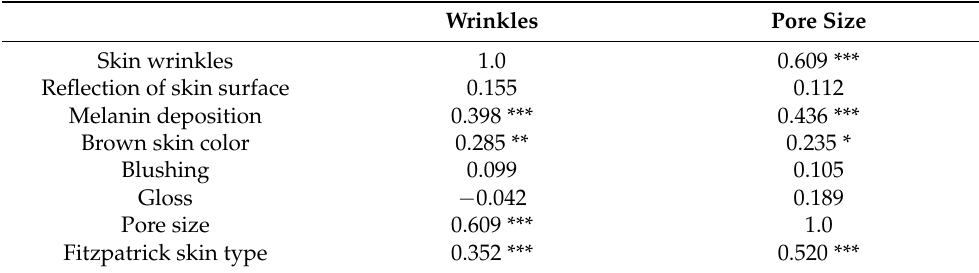
Table 6. Pearson correlation coefficients of skin evaluation scores with wrinkles and pore size.